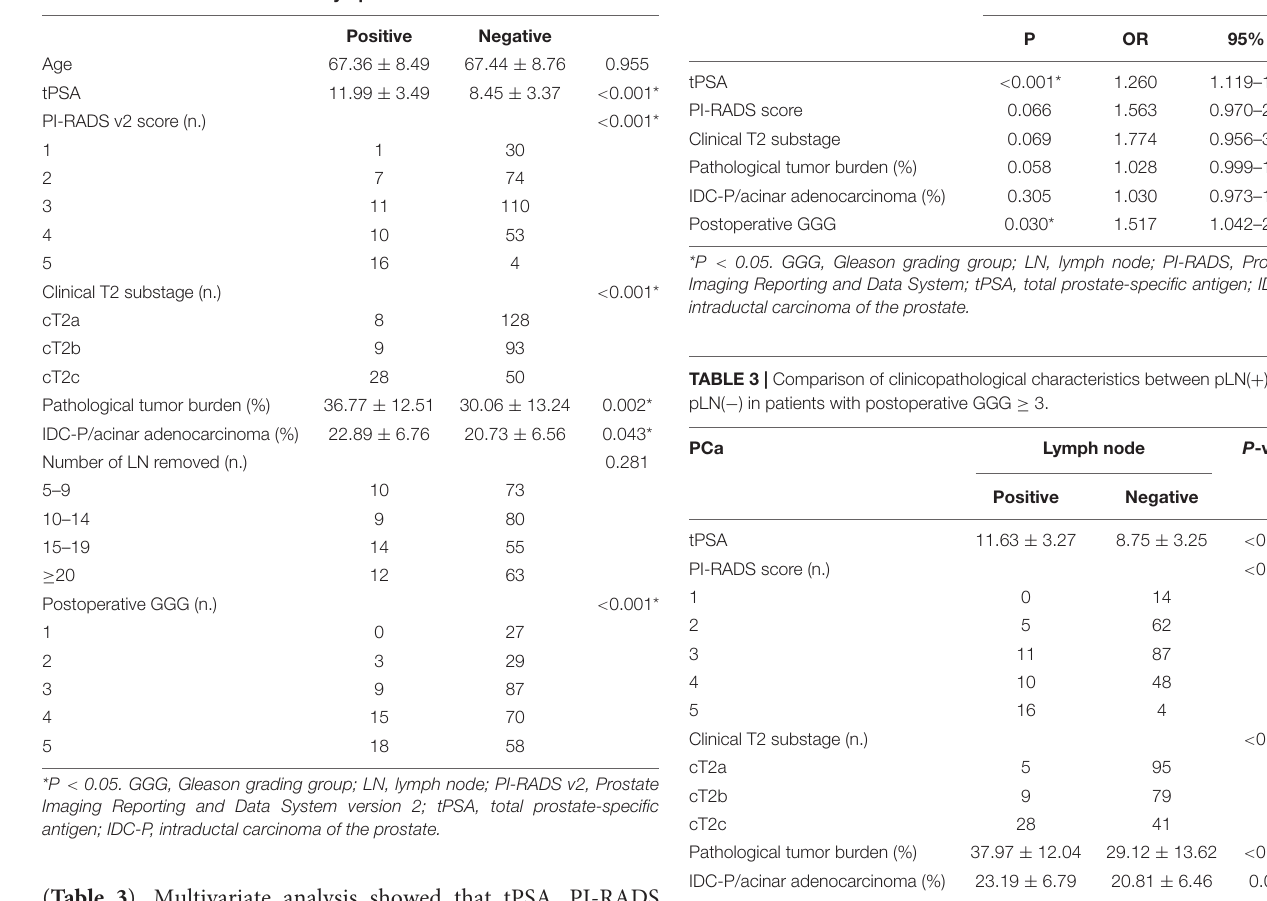
TABLE 1 | Comparison of clinicopathological characteristics between pLN( + ) and pLN( − ) in all patients. PCa Lymph node status